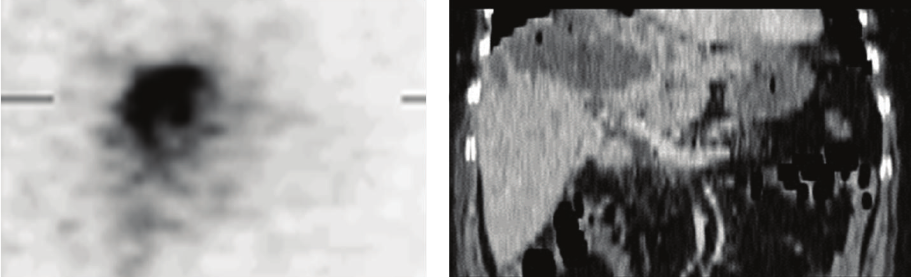
Figure 3: A patient with metastatic colon cancer treated with 296 MBq 32 P particles. It shows a perfect concordance of Bremsstrahlung and CT images (grade